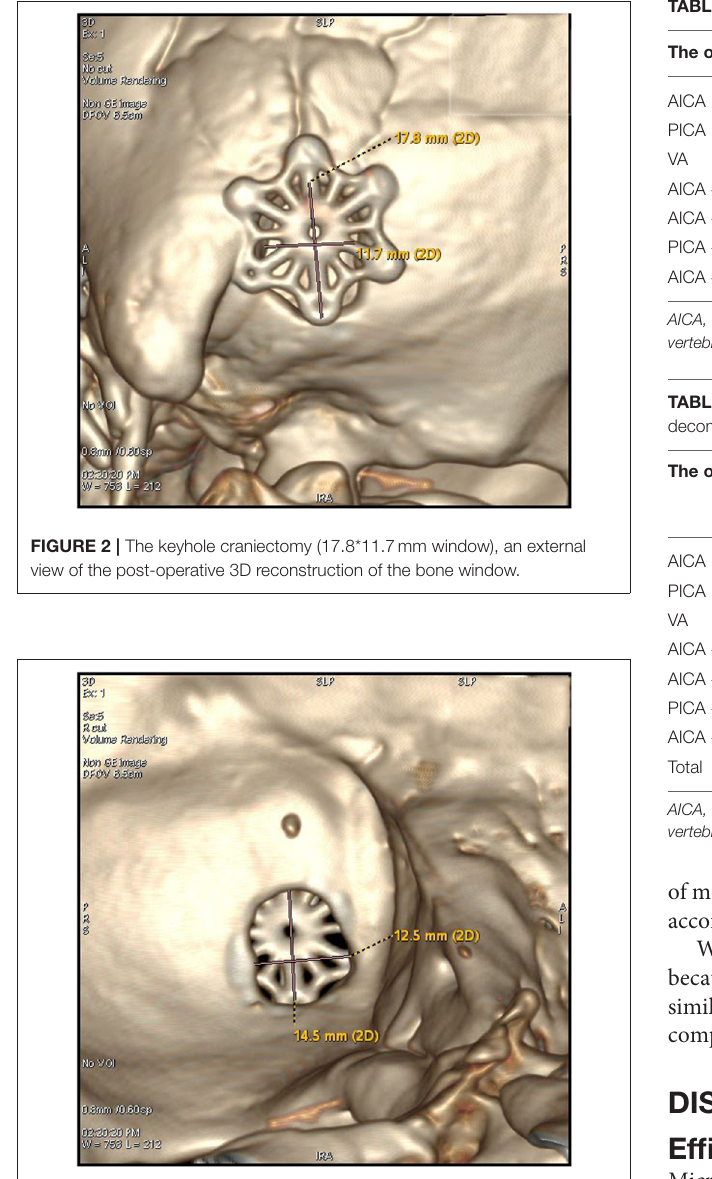
FIGURE 3 | The keyhole craniectomy (14.5*12.5mm window), an internal view of the post-operative 3D reconstruction of the bone window.